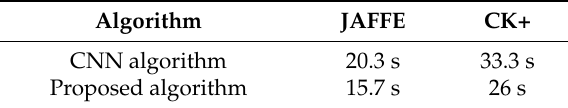
Table 10. The training times